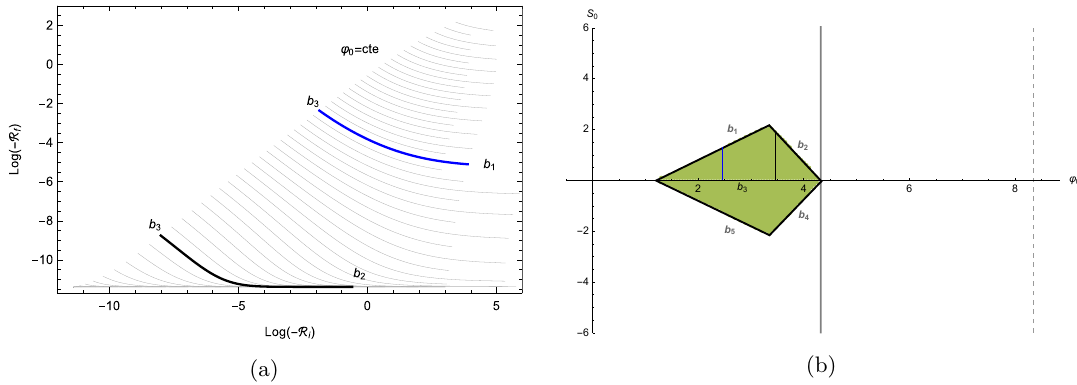
Figure 18 . The relation between two dimensionless curvatures at fixed ϕ 0 . The blue curve is a typical curve between two boundaries b b 2 and b 3 boundaries. These curves are in a one-to-one relation with the blue and black lines in figure